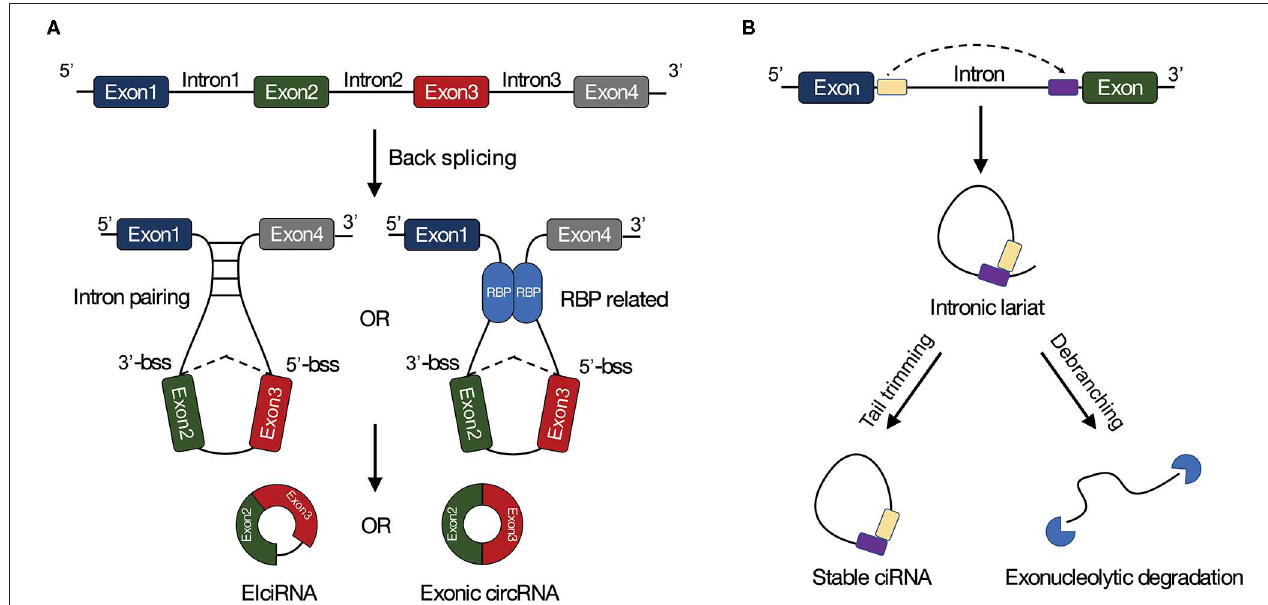
FIGURE 1 | Biogenesis of circRNAs. (A) Long flanking introns, inverted repeat elements, and RNA binding proteins are facilitated to back-splicing. (B) Circular intronic RNAs (ciRNAs) can be generated from intronic lariat precursors that escape from debranching. Bss, back-splice site; EIciRNA, exon-intron circRNA; ciRNA, circular intronic